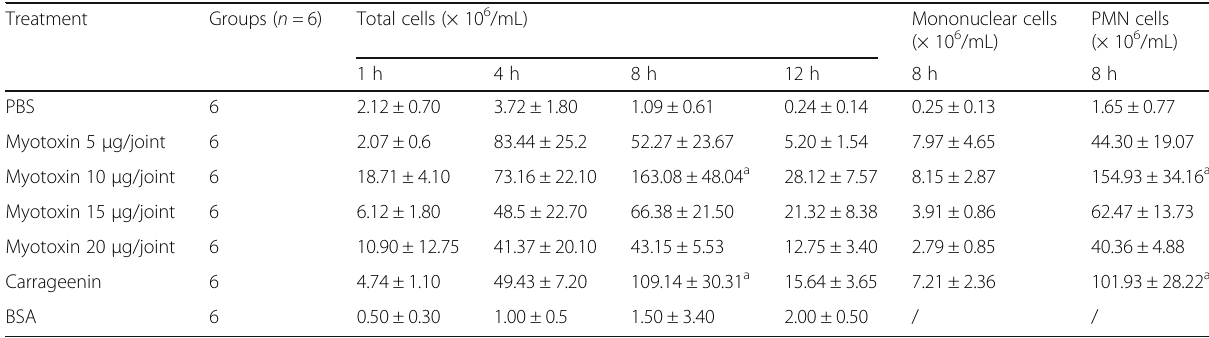
Table 1 Myotoxin-induced cell migration to the joint Treatment Groups ( n =